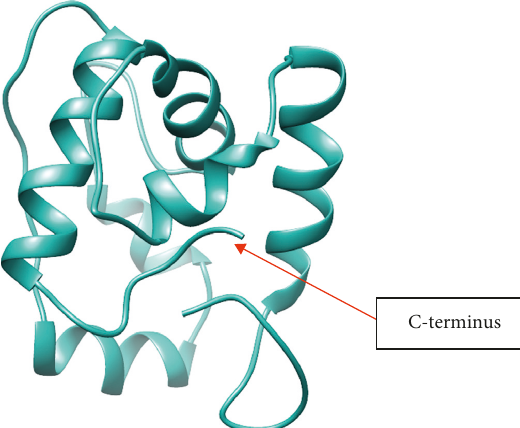
Figure 2: The best 3D OBP model built from MODELLER.